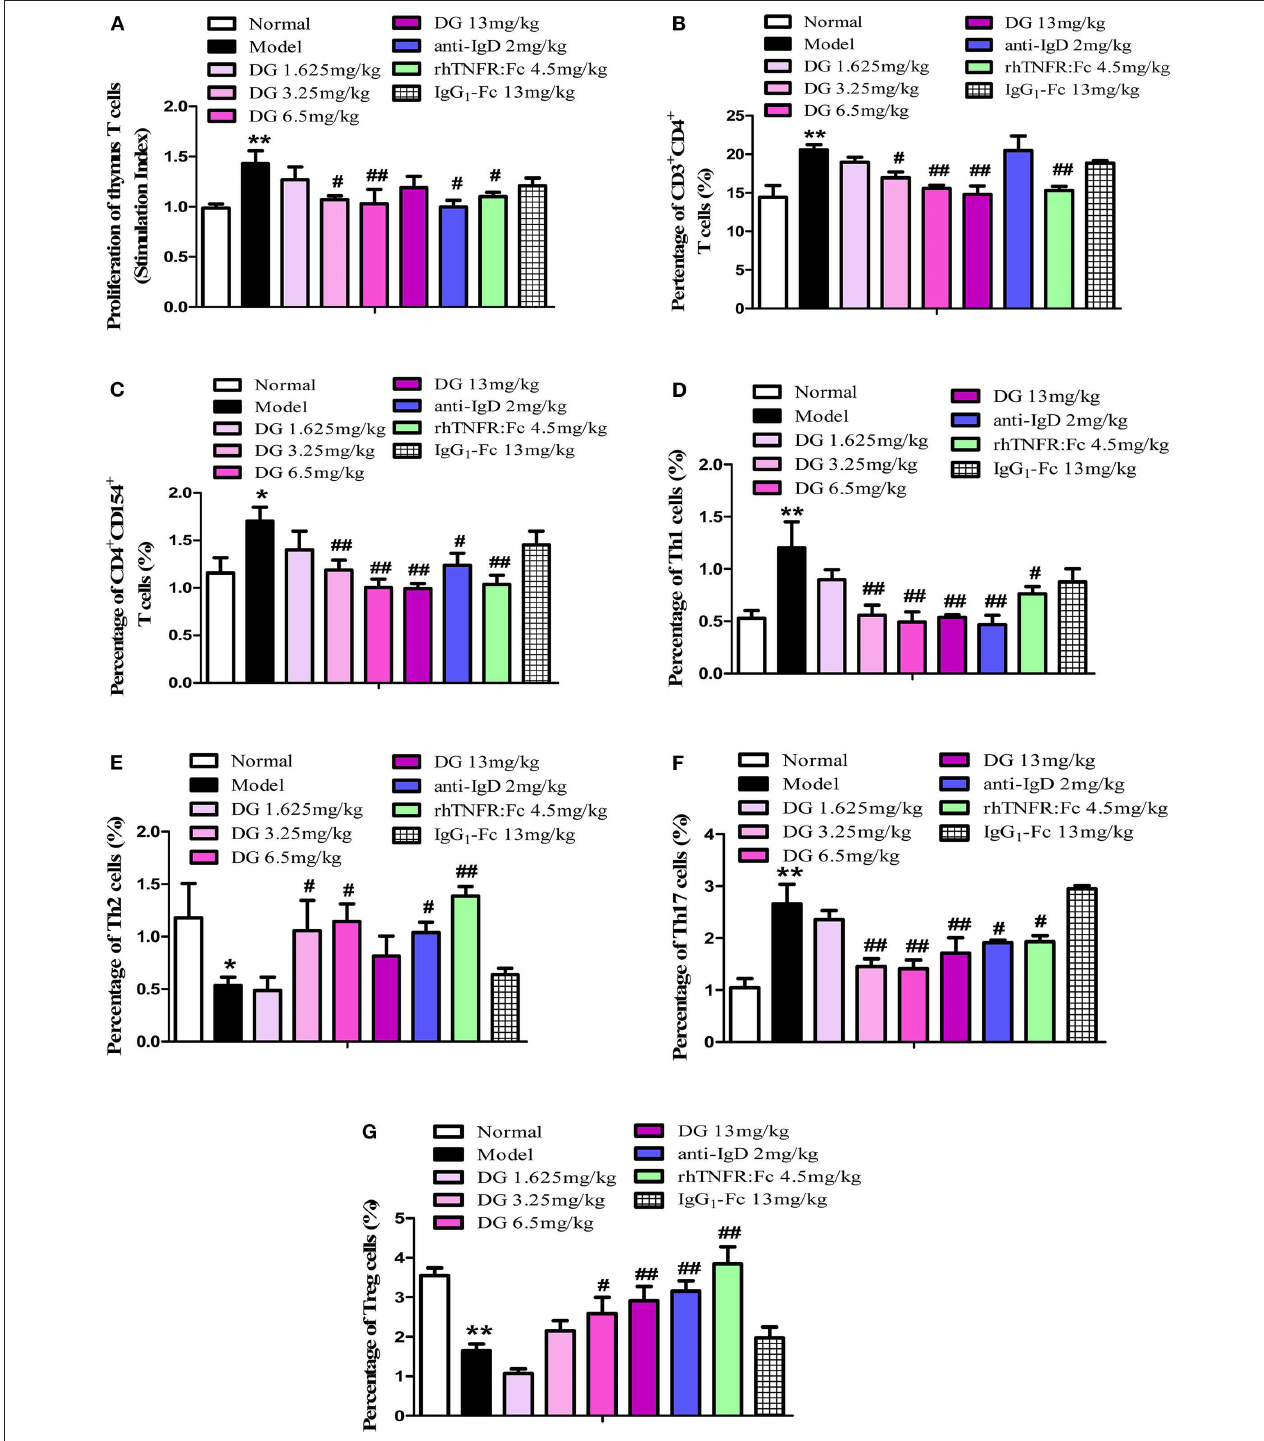
FIGURE 7 | Effects of IgD-Fc-Ig (DG) on the T cells functions of CIA mice. (A) Effects of IgD-Fc-Ig on the proliferation of thymus T cells. Effects of IgD-Fc-Ig on the percentage of CD3 + CD4 + (B) , CD4 + CD154 + (C) , Th1 (CD4 + IFN γ + ) (D) , Th2 (CD4 + IL4 + ) (E) , Th17 (CD4 + IL17 + ) (F) , and Treg (CD4 + CD25 + Foxp3 + ) (G) . Data were expressed as mean ± SEM (For each group 4–6 mice). * P < 0.05 and ** P < 0.01 vs. Normal, # P < 0.05 and ## P < 0.01 vs. Model.